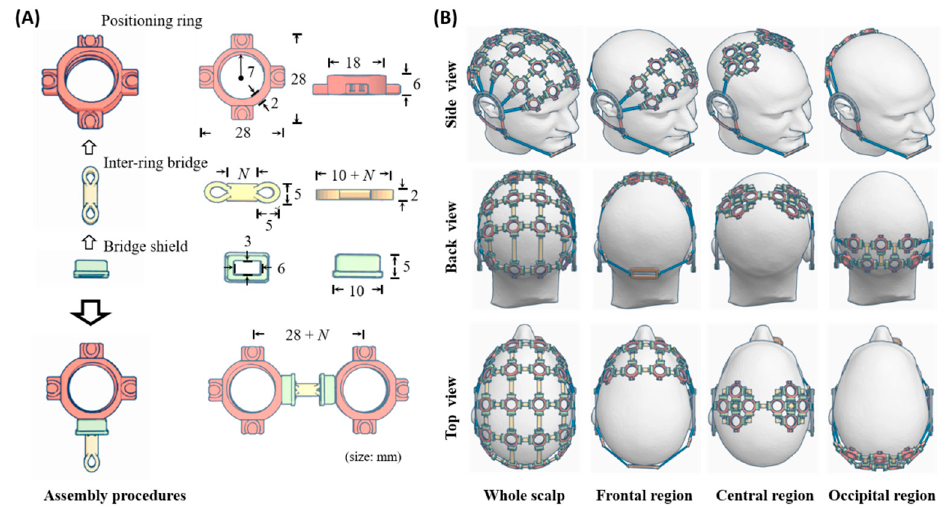
Figure 1. Illustration of the developed electrode-holder assembly infrastructure. ( A ) Three primary components and their assembly procedures. The sizes are in millimeter ( N = 11, 13, 40, and 50 used in this work); ( B ) four assembly embodiments with coverages of the entire scalp and individual regions of interest (simulated by 3D design software).